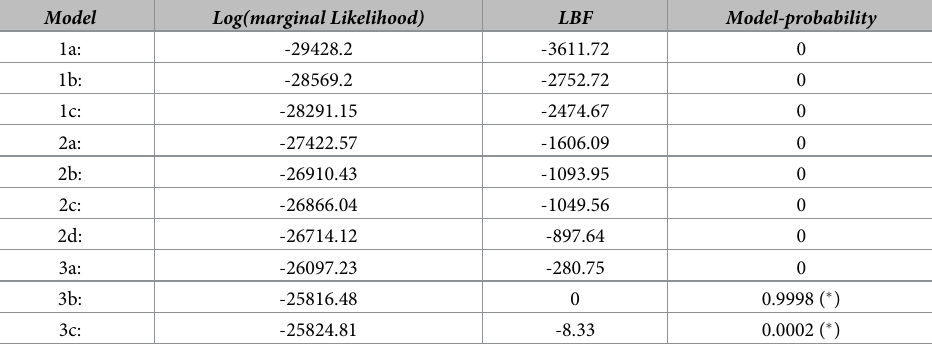
Table 6. Probability of models proposed to analyze possible events of gene flow and colonization.